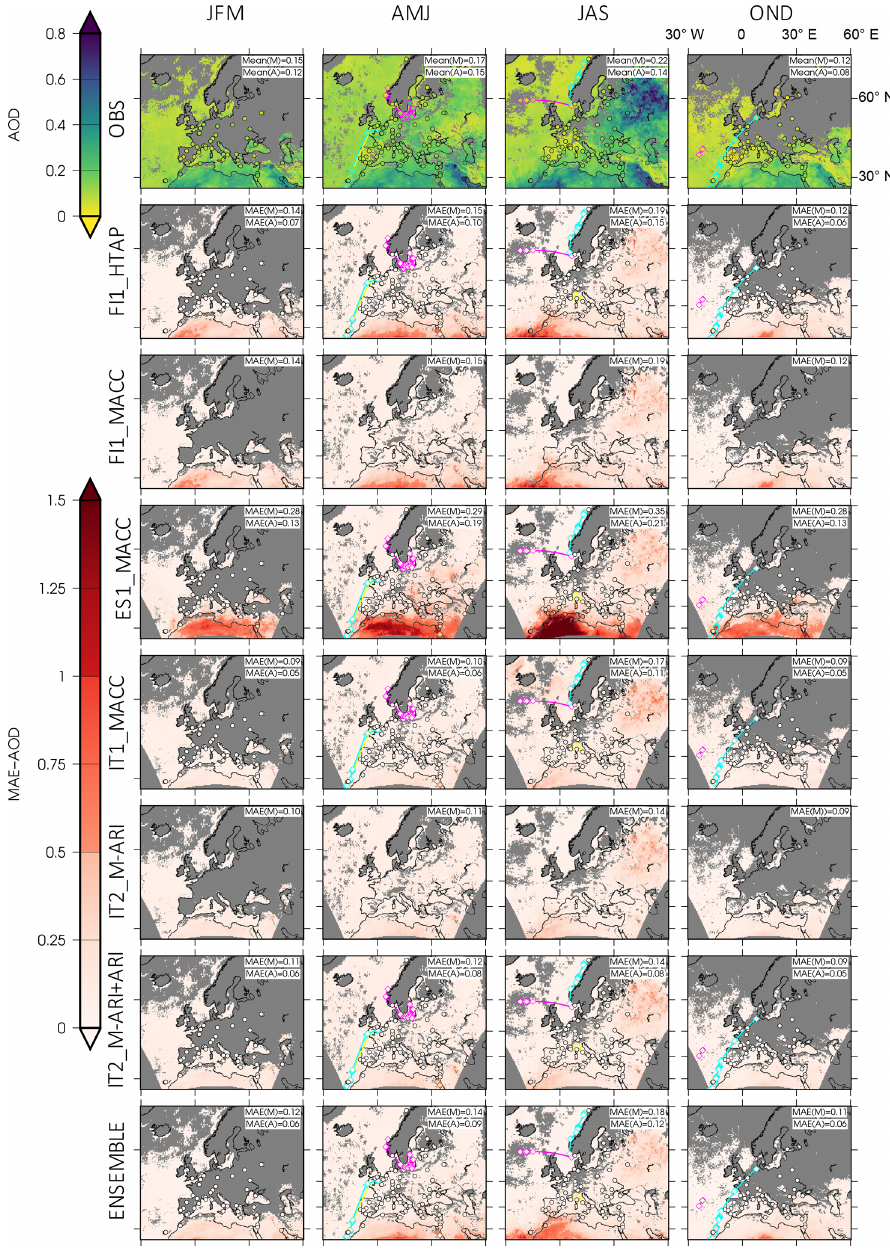
Figure 3. The same as Fig. 2 for the MAE